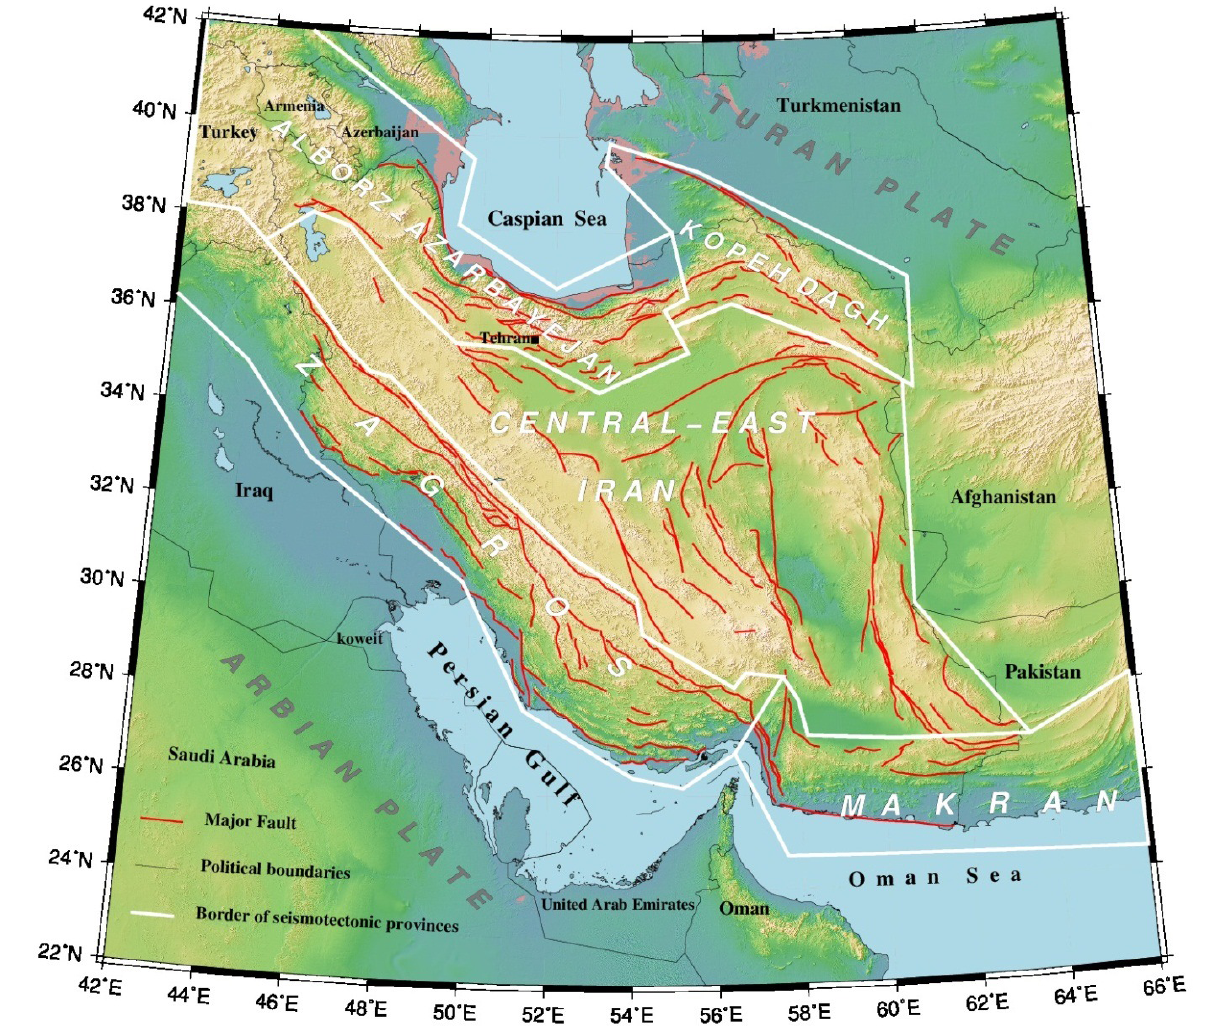
Figure 1. Major sismotectonic provinces of Iran developed by Mirzaei et al. [1998]. The Red lines depict the major active faults developed by Hessami et al.